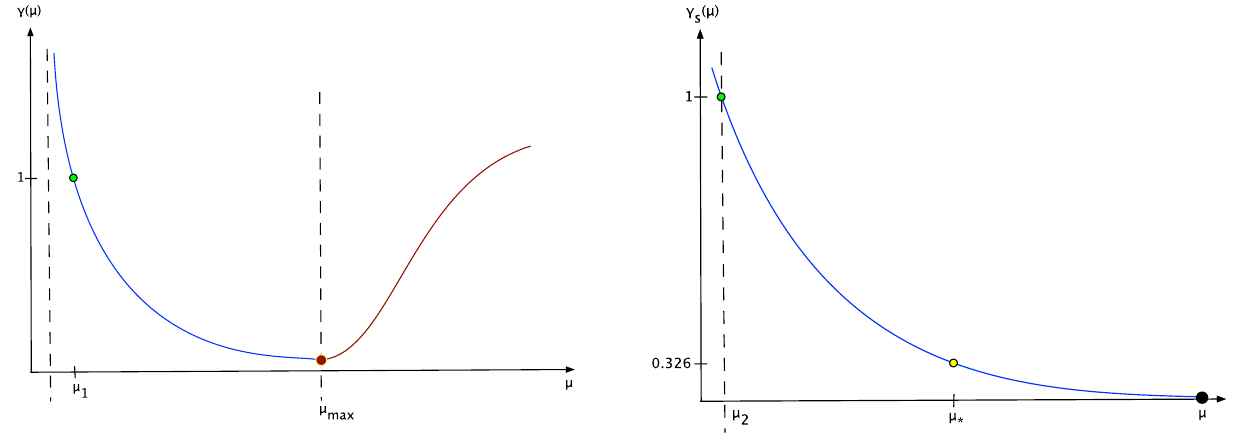
Fig. 5 The running of the anisotropy γ(μ) as a function of the dynam- ical scale. The green bullet represent the scale μ 1 where the anisotropy becomes γ(μ 1 ) = 1 while the red one shows γ min ≡ γ(μ max ) , the min- imum value of the anisotropy. The behaviour of γ between the dashed lines (blue curve) resembles the bulk-driven phase transition of Fig. 1. Passing towards μ max the running of the anisotropy (red line) changes its behaviour and increases with increasing μ